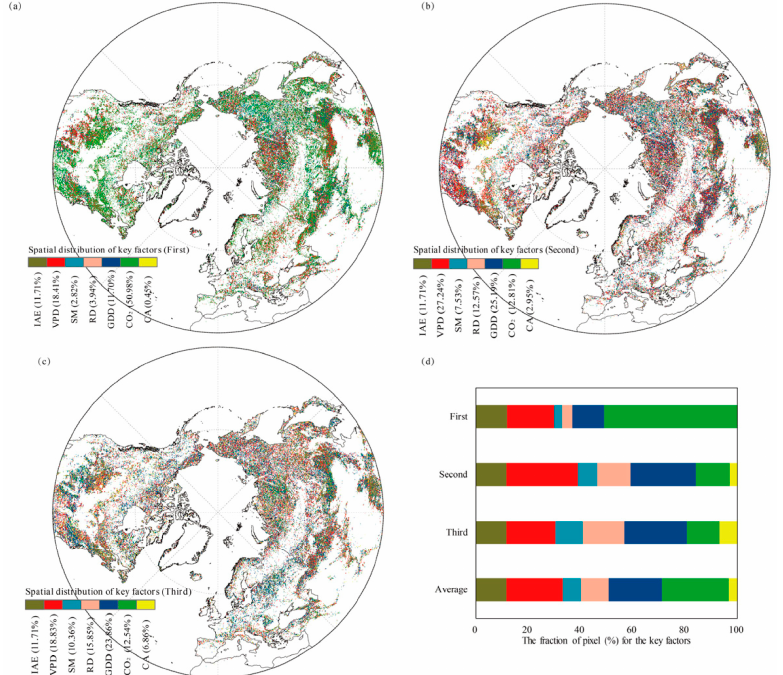
Figure 3. Spatial distribution of the drivers of RVG trends, defined as the driving factor that con- tributes ( a ) first, ( b ) second, and ( c ) third to the RVG trends in each pixel over the northern extratropics. ( d ) The fraction of pixel (%) for the key factors (note: IAE indicates that the relative importance of the interactive effects ( RI IAE ) exceeds 50% (meaning the interactions are dominant), so its percentage remains constant).